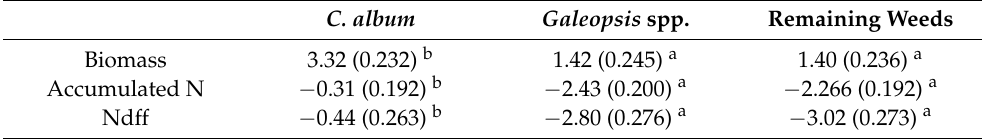
Table A3. Estimates of ln-transformed mean biomass, N accumulation and absolute amount of N derived from fertilizer (Ndff) of Chenopodium album , Galeopsis spp . and the remaining weeds corresponding to back-transformed medians presented in Table 3. Different letters indicate signif- icant differences between the species following pairwise comparison (Tukey, α = 0.05) based on ln-transformed data. Standard errors are given in